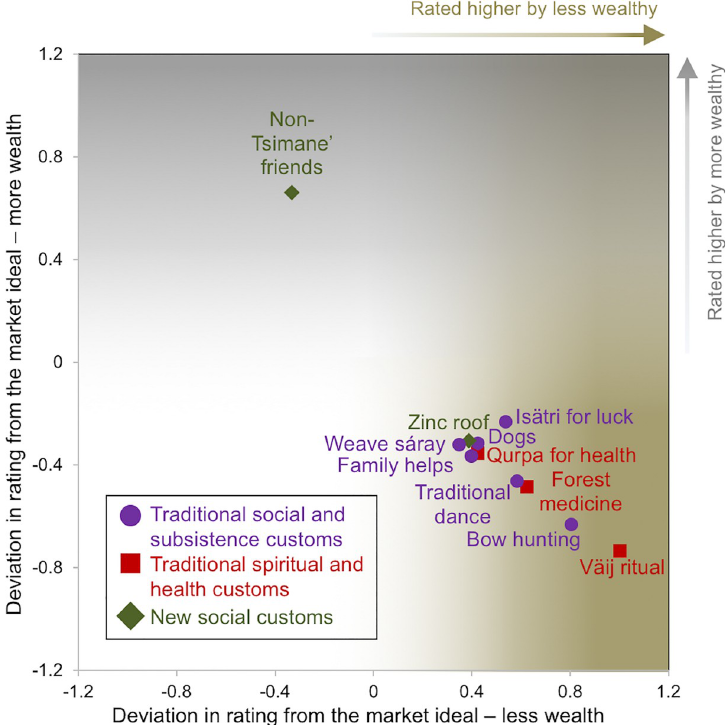
Fig 7. Items and characteristics that deviate most ( ± ) from the market lifestyle among respondents in dichotomized wealth groups. Higher positive deviation scores on the Y-axis and within the grey gradient indicate higher ratings from those with more wealth. Higher positive numbers on the X-axis and within the brown gradient indicate higher ratings from those with less